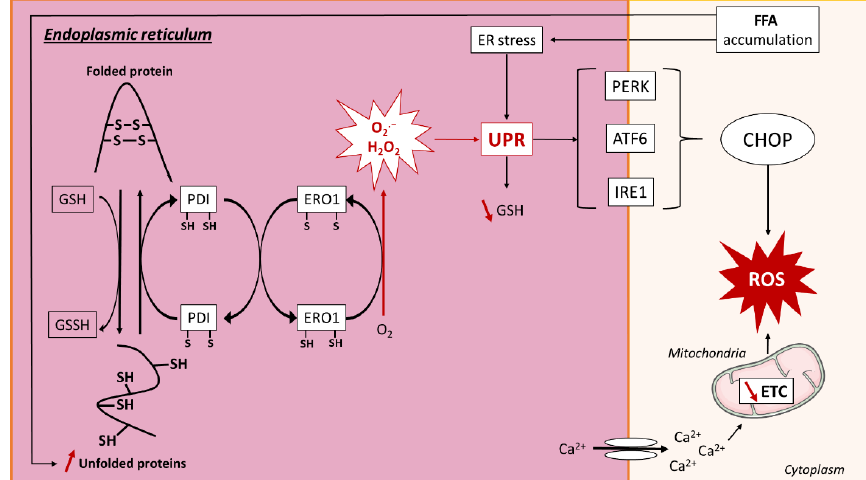
Figure 5. ROS production in endoplasmic reticulum. Lipid overload causes accumulation of unfolded proteins in the endoplasmic reticulum (ER) by the reduction of reduced glutathione (GSH) to oxidized glutathione (GSSH), resulting in the breakage of protein disulfide bonds (SH). The ER resident proteins, protein disulfide isomerase (PDI) and ER oxidoreductin 1 (ERO1), are involved in disulfide bond formation and superoxide (O 2. − ) and hydrogen peroxide (H 2 O 2 ) release through electron transfer. ROS production and ER stress activate the unfolded protein response (UPR), which leads to a decrease in GSH. UPR is regulated by three transmembrane proteins: protein kinase RNA-like ER kinase (PERK), activating transcription factor 6 (ATF6), and inositol-requiring signaling protein 1 (IRE1), which promote the transcription of CCAAT/enhancer-binding protein homologous protein ( CHOP ) that further induces ROS generation. ER stress is associated with reduced sarco/endoplasmatic reticulum Ca 2+ -ATPase (SERCA) activity, leading to calcium leakage and decreased mitochondrial electron transport chain (ETC) activity, resulting in ROS production. Other abbreviations: O 2 , oxygen; FFA, free fatty acid; ROS, reactive oxygen species; Ca 2+ , calcium.